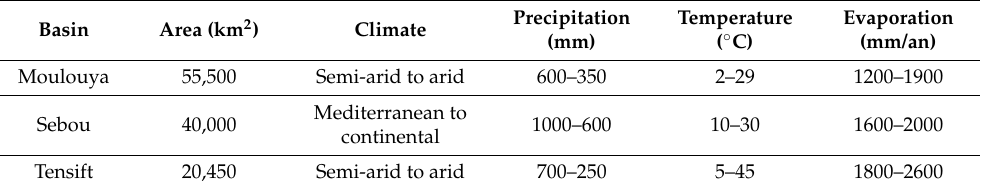
Figure 1. The study area (Moulouya, Sebou, and Tensift basins). Table 1. Climatic characteristics of the study basins.